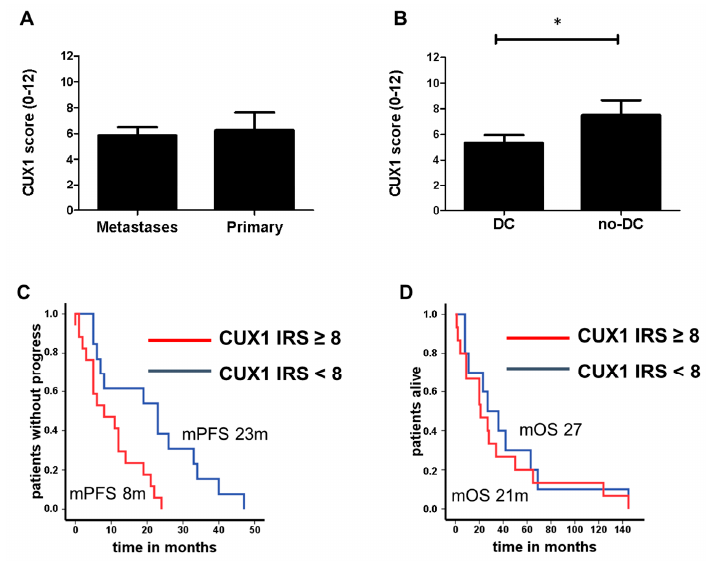
Figure 2. ( A ) CUX1 IRS in 43 PanNET tissues (35 metastases and 8 primary tumours) of 31 patients treated with chemotherapy (mean: 5.9 ± 0.6 SEM vs. 6.3 ± 1.4 SEM, P = 0.79). ( B ) CUX1 IRS in patients with disease control (DC, N = 31, mean: 5.3 ± 0.6 SEM) versus progressive disease (no ‐ DC, N = 12, mean: 7.5 ± 1.2 SEM) * P = 0.045. ( C ) PFS in patients with predefined CUX1 IRS ≥ 8 (red line) compared to CUX1 IRS < 8 (blue line) ( D ) CUX1 IRS < 8 was 23 months (95% CI 5.8 to 40.2 months), CUX1 IRS ≥ 8 was 8 months (95% CI 0 to 16 months) ( P = 0.005, figure) and OS (D, mOS 27 vs. 21 months, P = 58).